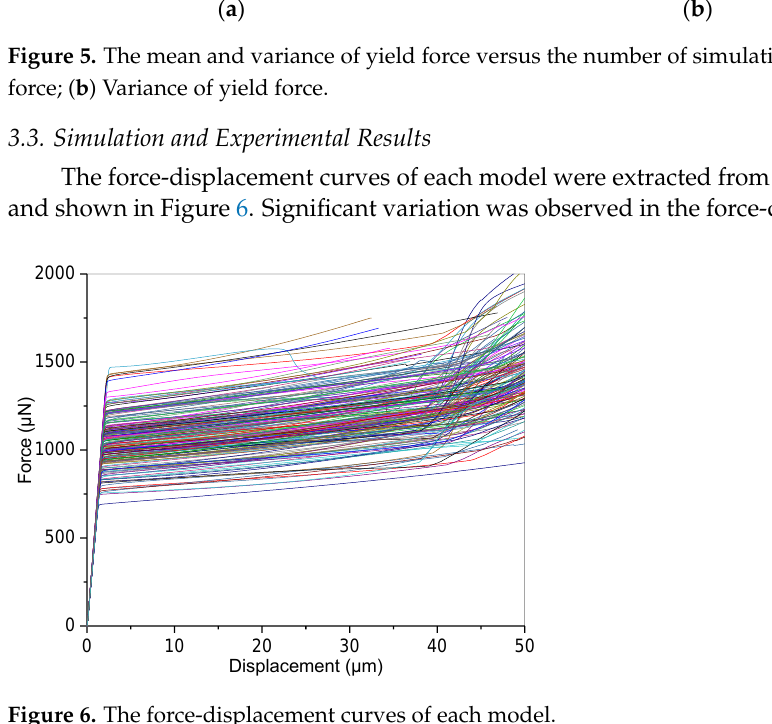
Figure 5. The mean and variance of yield force versus the number of simulations: ( a ) Mean of yield force; ( b ) Variance of yield force.